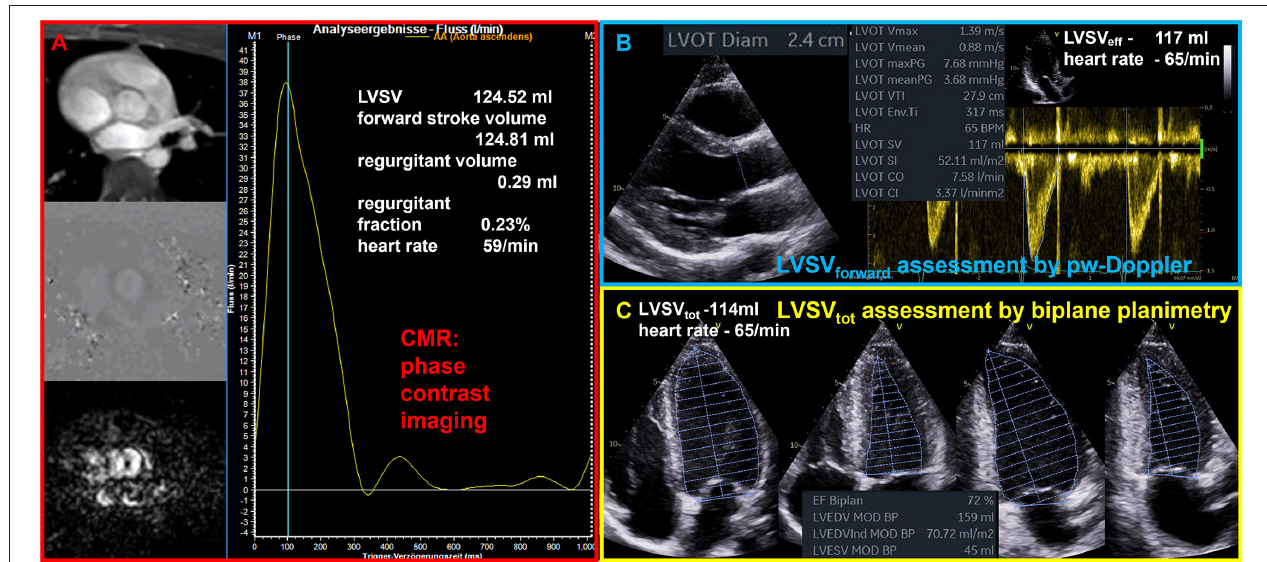
FIGURE 1 | Illustration of comparable quantitative assessment of left ventricular stroke volume (LVSV) by cardiac magnetic resonance tomography (CMR) and echocardiography. (A) Phase contrast imaging and assessment of forward flow through the aortic valve by CMR phase contrast imaging. (B) Assessment of forward LVSV through the aortic valve by pulsed wave (pw) Doppler (LVSV forward ); LVSV forward is the effective LVSV (LVSV eff ) as well as the total LVSV (LVSV tot ) during normal conditions. (C) Assessment of LVSV tot by biplane